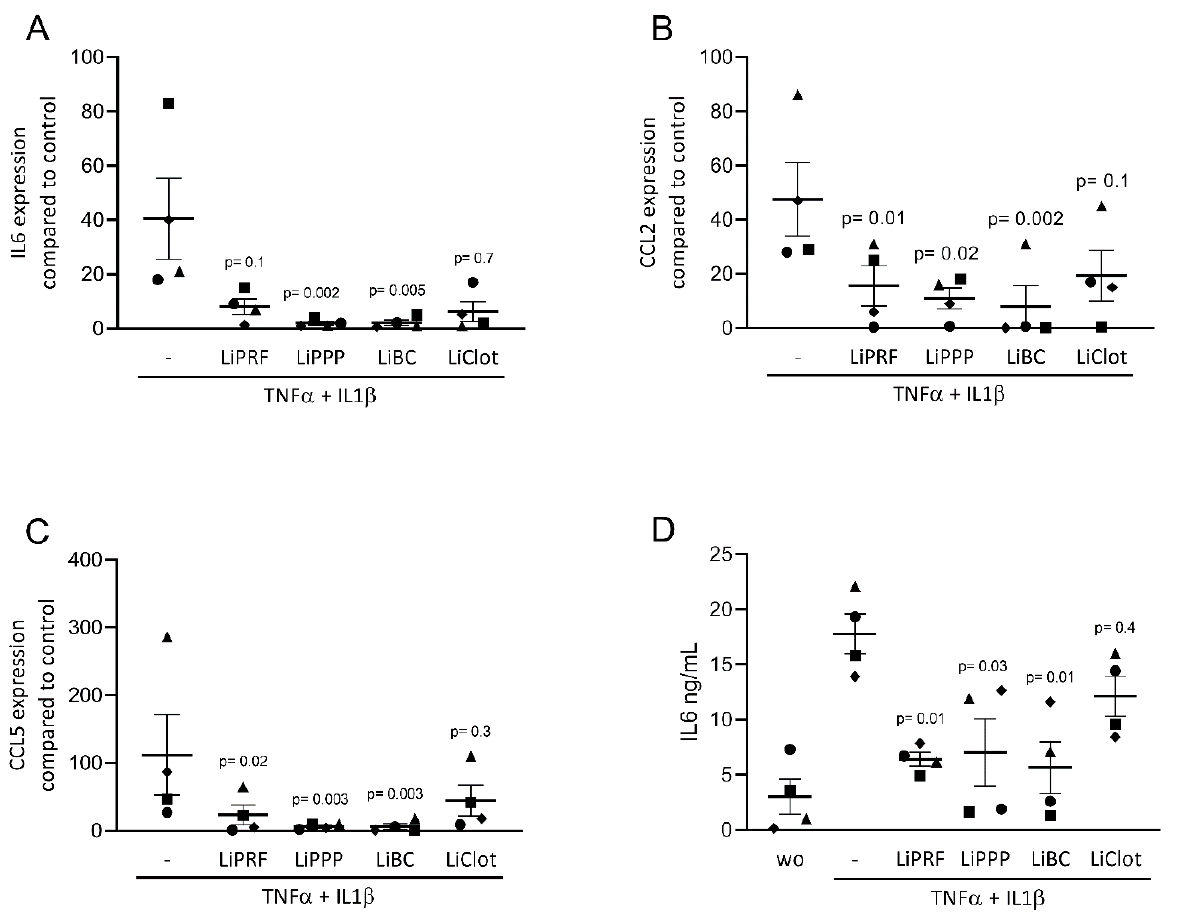
Figure 1. Lipids from PRF reduces the expression of inflammatory-related genes in cytokine-induced ST2 cells. ( A – C ) A reduction in IL6, CCL2 and CCL5 in cytokine-induced ST2 cells was reported in the presence of lipid extracts from solid PRF (LiPRF) and liquid PRF (LiPPP and LiBC); with blood clot (LiClot) it was a tendency. ( D ) Data show the IL6 protein levels in the cell supernatant. Each data point represents an independent experiment. N = 4. For comparison of groups, the Friedman test was applied. WO means without and represents unstimulated cells.